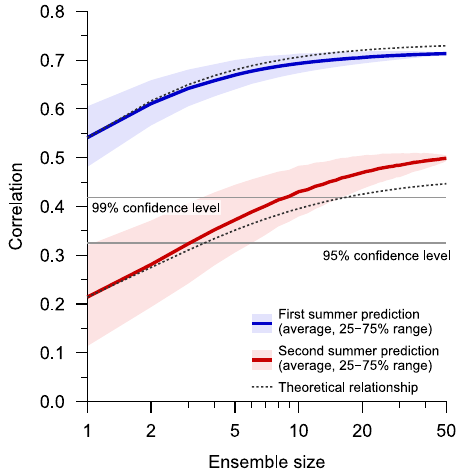
Fig. 4 Prediction skill dependency on ensemble size. Correlation coef fi cients of the WNP monsoon index for the fi rst (blue line) and second (red line) summers. Medians (thick lines) and 25 – 75% ranges (colour shading) are estimated by using a bootstrap method (10,000 resamplings of ensemble members with a fi xed retrospective prediction period). The theoretical estimates 45 are shown based on averages of 1-member correlation skills (Methods). The statistical signi fi cance levels are based on Student ’ s t